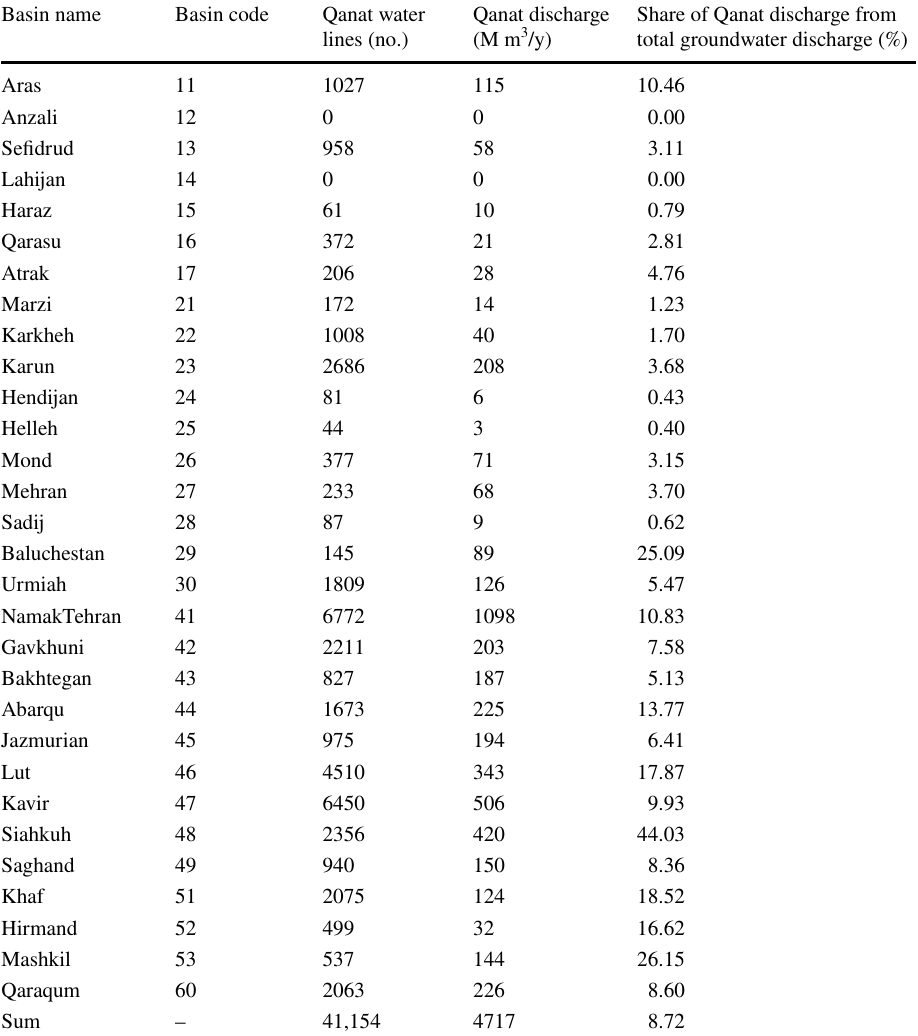
Basin name Basin